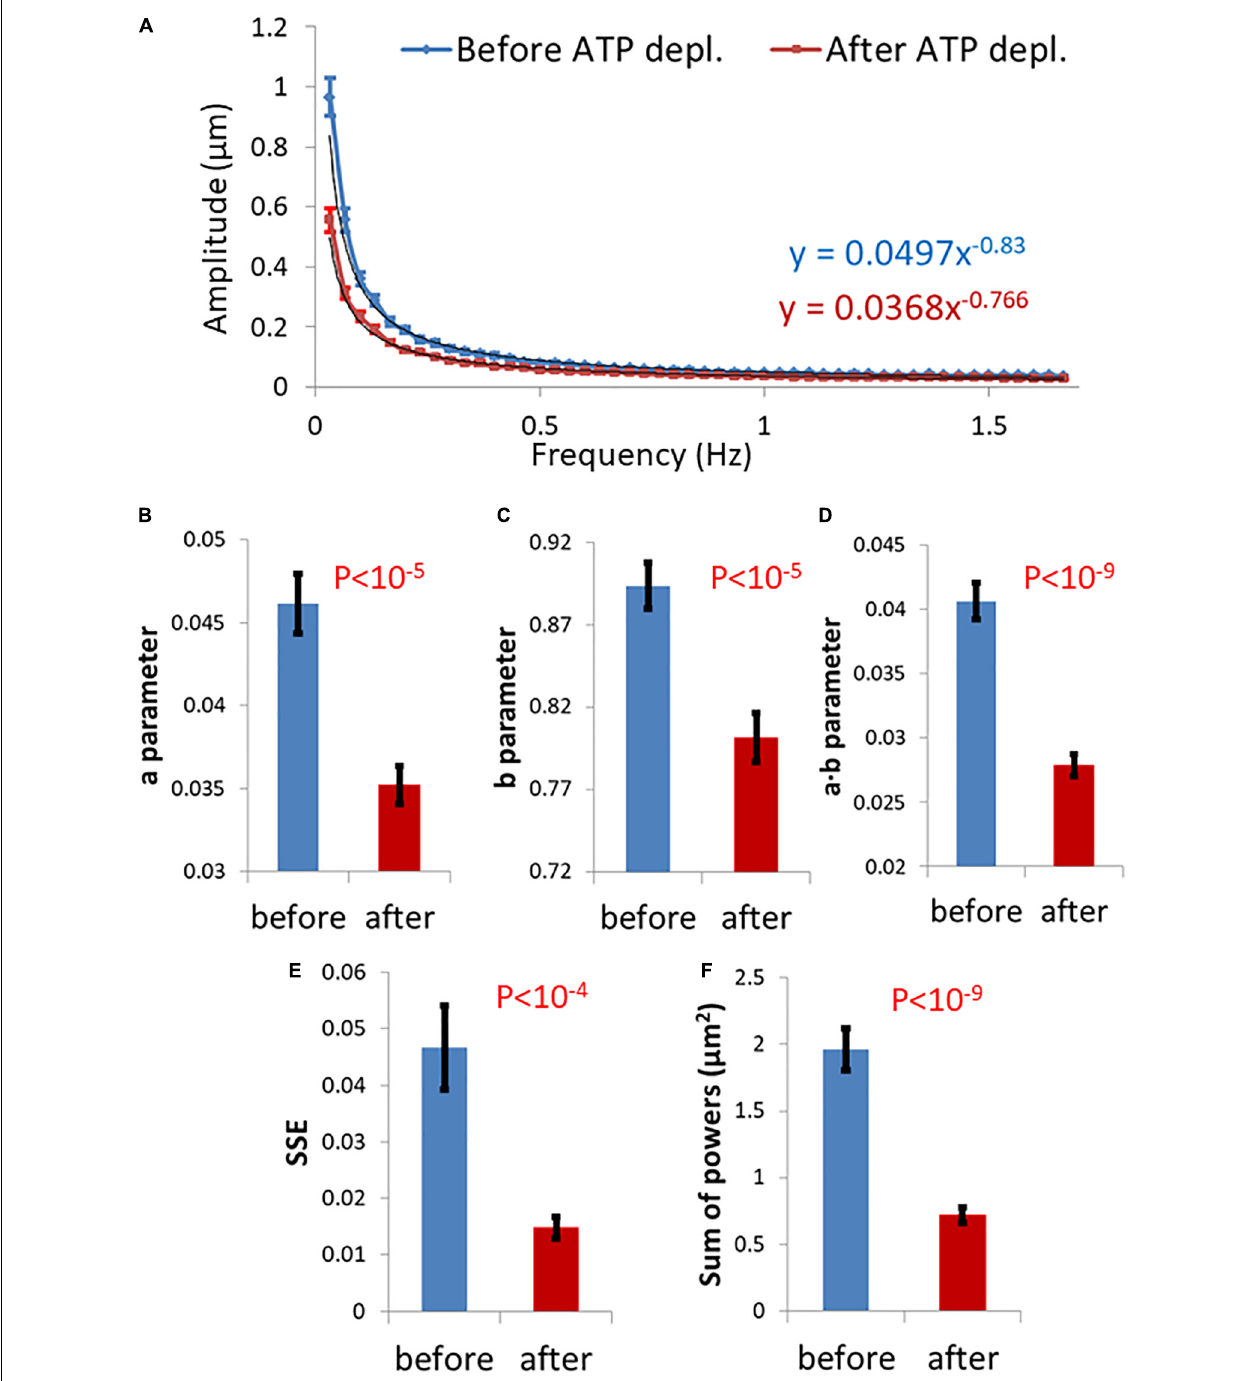
FIGURE 3 | Differential Interference Contrast (DIC) microscopy results of intracellular particles motion in live cells before and after adenosine triphosphate (ATP) depletion analyzed by amplitude spectral density (ASD) and power spectral density (PSD). (A) ASD analysis results in ( n = 29) cells before (blue line) and after (red line) ATP depletion and the corresponding power fit parameters. (B–E) Power fit parameters: a , b , a · b , and SSE for the ASD analysis results in the cells [in (A) ] before and after ATP depletion. (F) Power fit parameter “ Sum of powers ” for the PSD analysis results in the cells [in (A) ] before and after ATP depletion. Error bars in panels (A–F) are